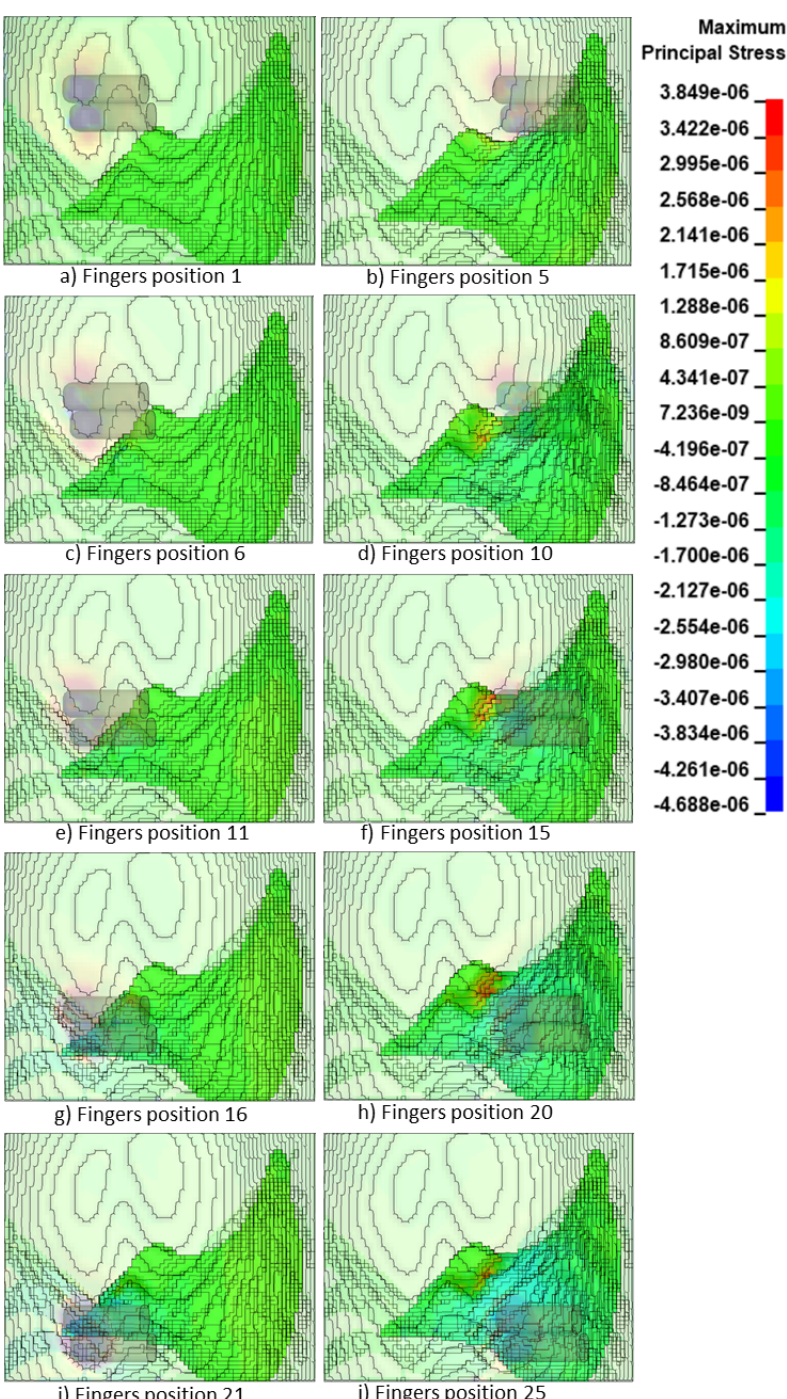
Figure 8. Simulation results illustrating the maximum principal stress distributions (in GPa) on the elements of the liver tissue at maximum indentation of 15 mm for each of the first and last horizontal positions of fingers according to Figure